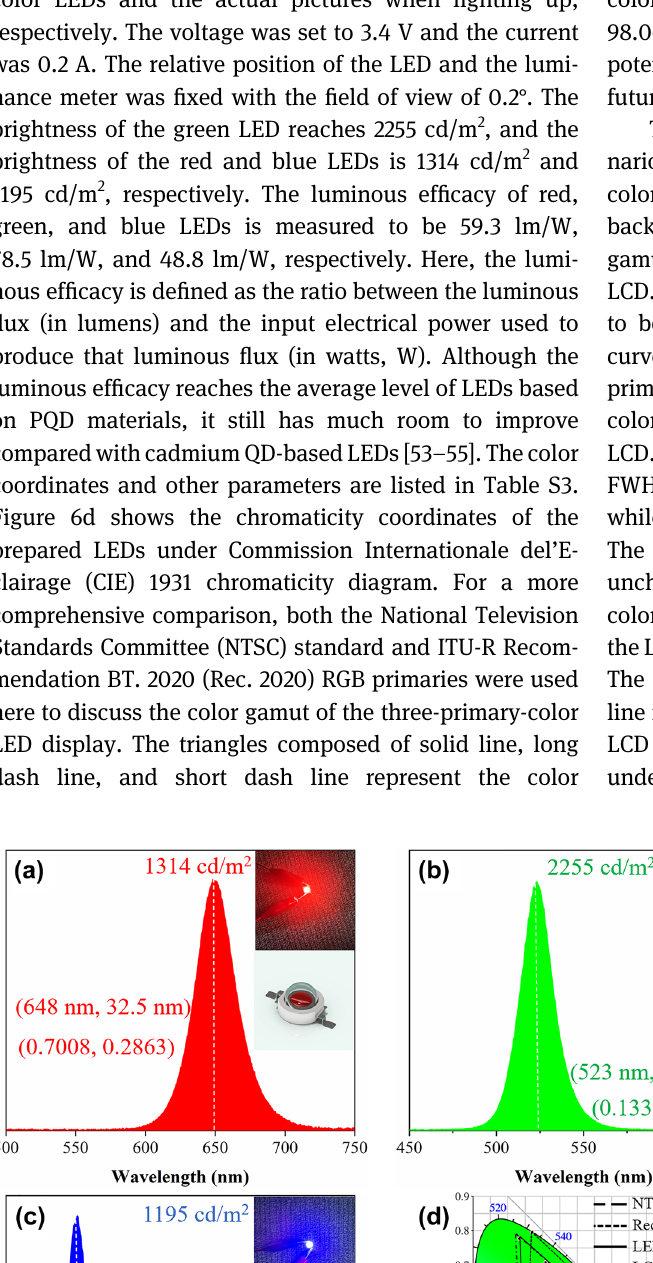
Figure 6: (a) – (c) The spectra of the three- primary-color LEDs and their working photo- graphs; (d) the CIE chromaticity diagram of the direct-view LED display and the LCD compared with the NTSC and Rec. 2020